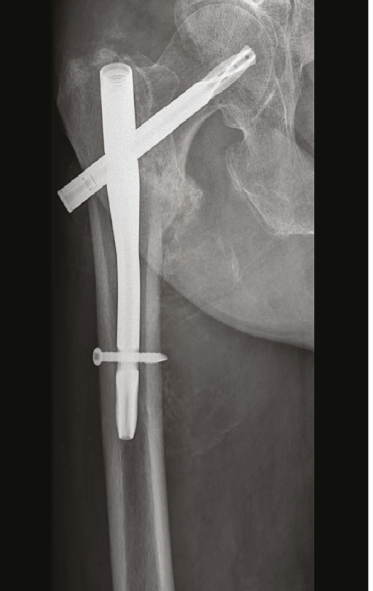
Figure 2: Plain X-ray of the right hip six weeks postoperatively showed a good position of the intramedullary